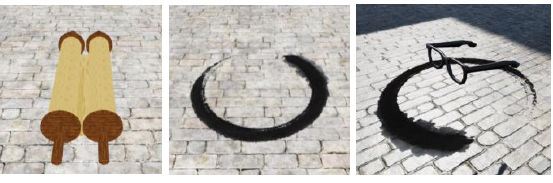
Figure 7. Reel, Ink circle and